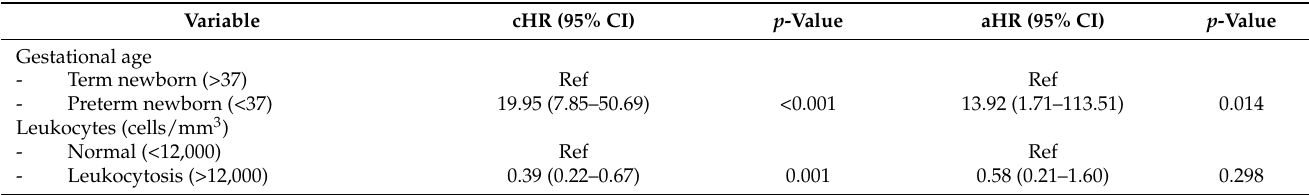
Table 3. Cox regression model 1 to find predictors of mortality in patients with neonatal